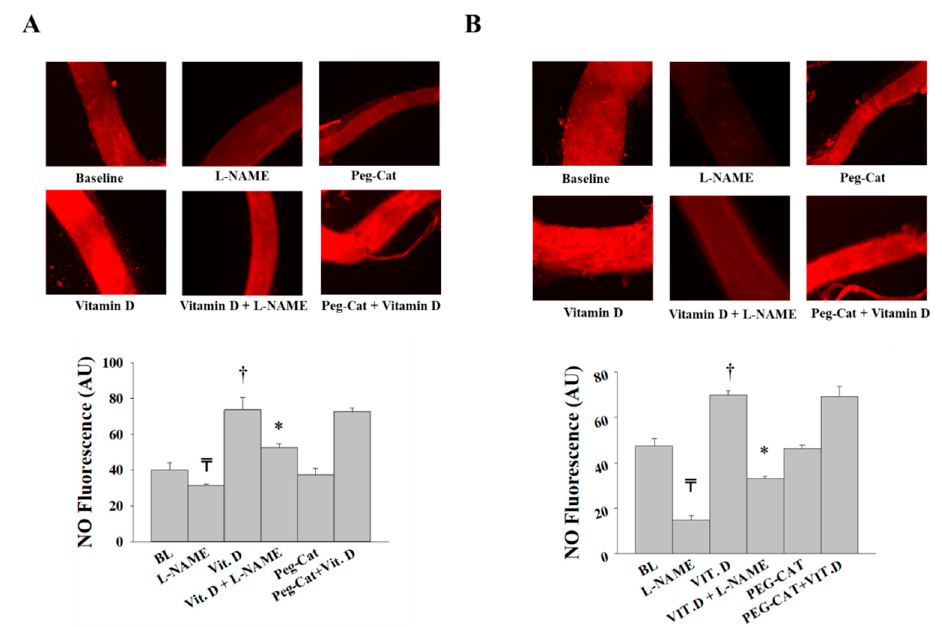
Figure 6. Nitric oxide (NO) production in isolated adipose tissue arterioles collected on the day of surgery. Representative images by fluorescence microscopy of NO generation conditions at baseline and after incubation with L-NAME, PEG-CAT, vitamin D, vitamin D plus L-NAME, and vitamin D plus PEG-CAT in VAT arterioles ( A ) and SAT arterioles ( B ). Charts represent NO fluorescent signals that were measured and expressed in arbitrary units using NIH Image J software. All measures are represented as means ± SE; ₸ p < 0.05 comparing L-NAME with baseline, † p < 0.05 comparing vitamin D with baseline, * p < 0.05 comparing L-NAME + vitamin D with vitamin D alone.